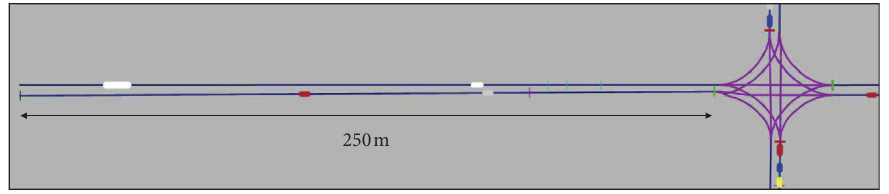
Figure 12: Geometric layout of an arm in the microsimulation. Table 6: Parameters in microscopic simulation.